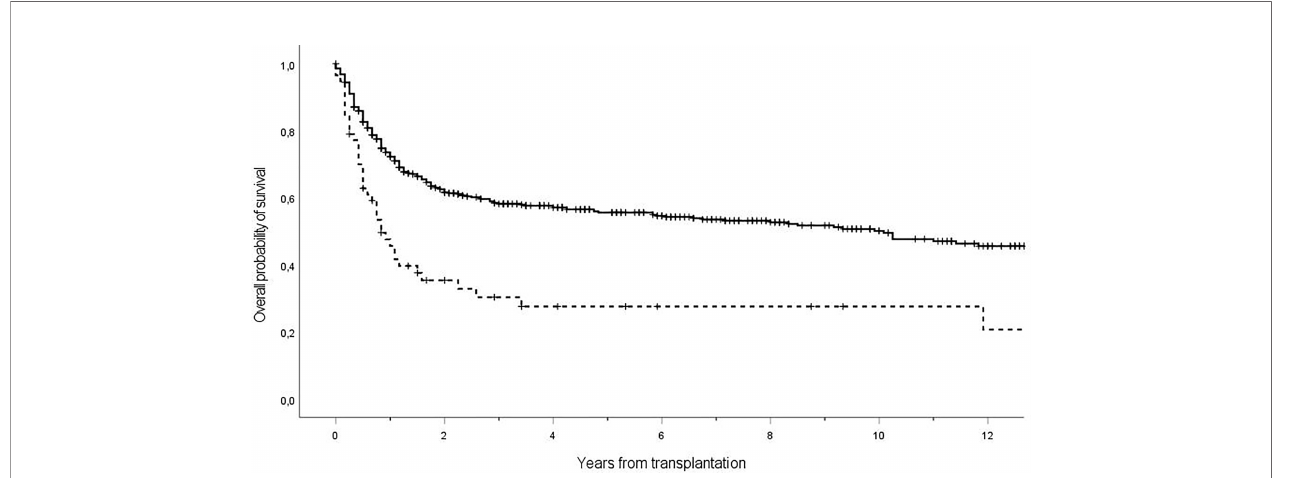
FIGURE 3 | Overall survival of patients receiving allogeneic transplant with diagnosis of IFI (dashed line) or not (solid line). The 1-year overall survival was 32.8% in patients IFI positive vs. 54.6% in patients IFI negative, with a statistically signi fi cant difference ( p < 0.001). Ticks on probability lines indicate dates of censoring at last